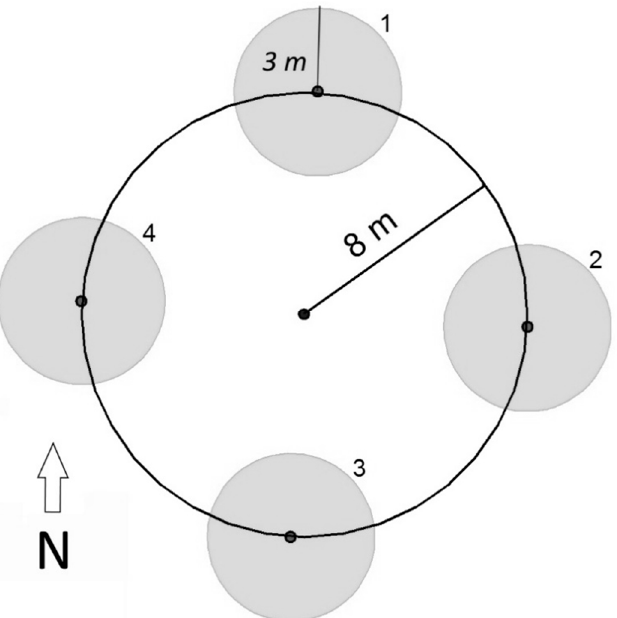
Figure 2. Each monitoring spot (MS) with a radius of 8 m consisted of four systematically distributed monitoring plots